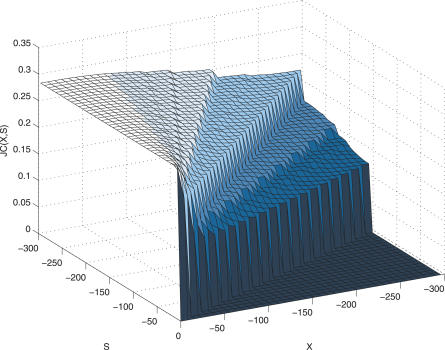
The Jukes–Cantor Distance Function of Two Drosophila Genomes